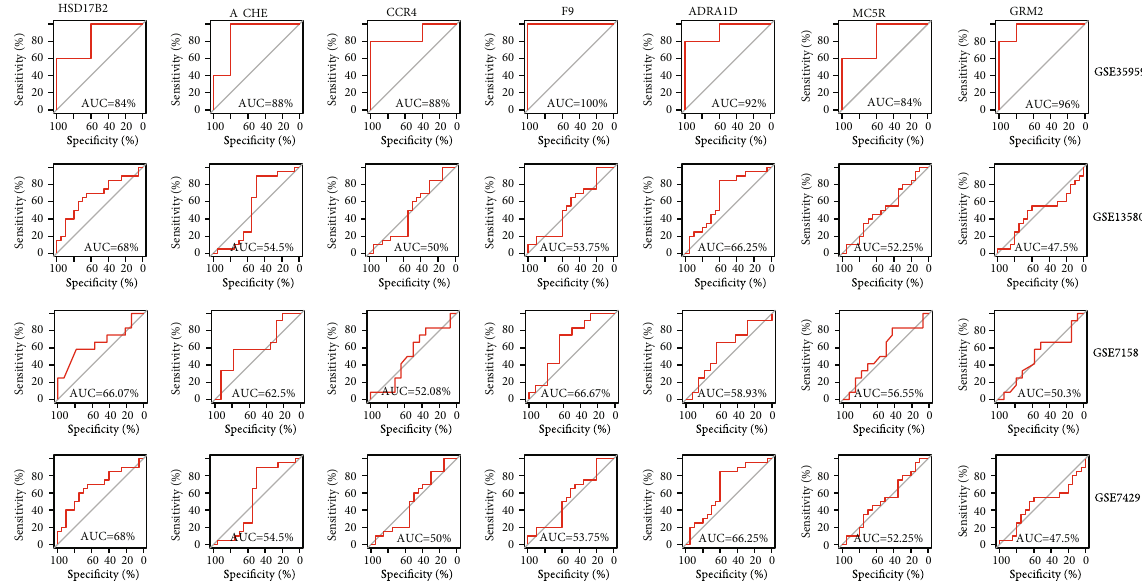
Figure 3: Individual ROC curves for 7 genes in GSE35959, GSE13580, GSE7158, and GSE7429 dataset.